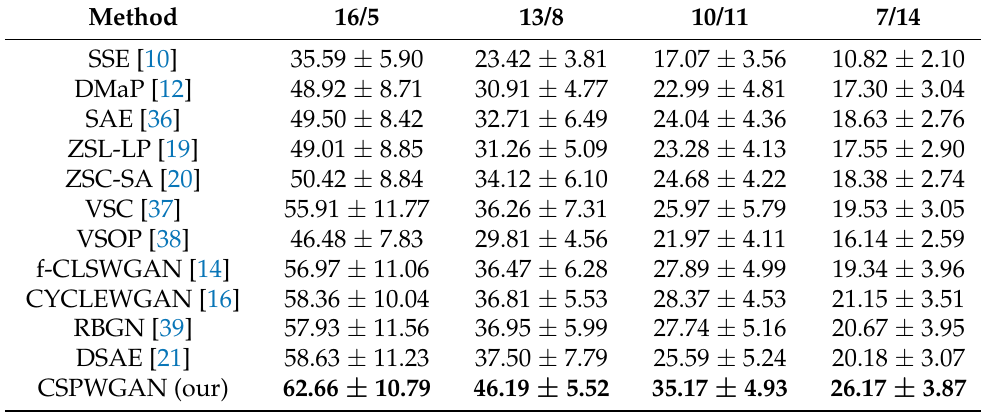
Table 2. With different seen/unseen ratios, the average ZSL classification accuracies and standard deviation (%) of our CSPWGAN model and the sota methods on the UCM21 dataset. Bold font denotes the best